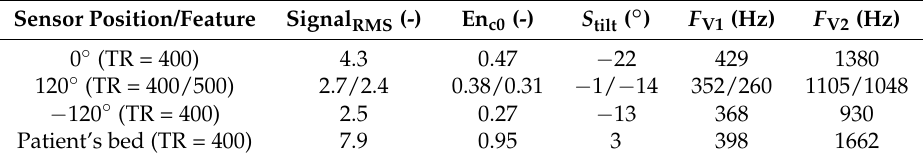
Table 2. Mean values of basic spectral features of the recorded vibration signals 1 .